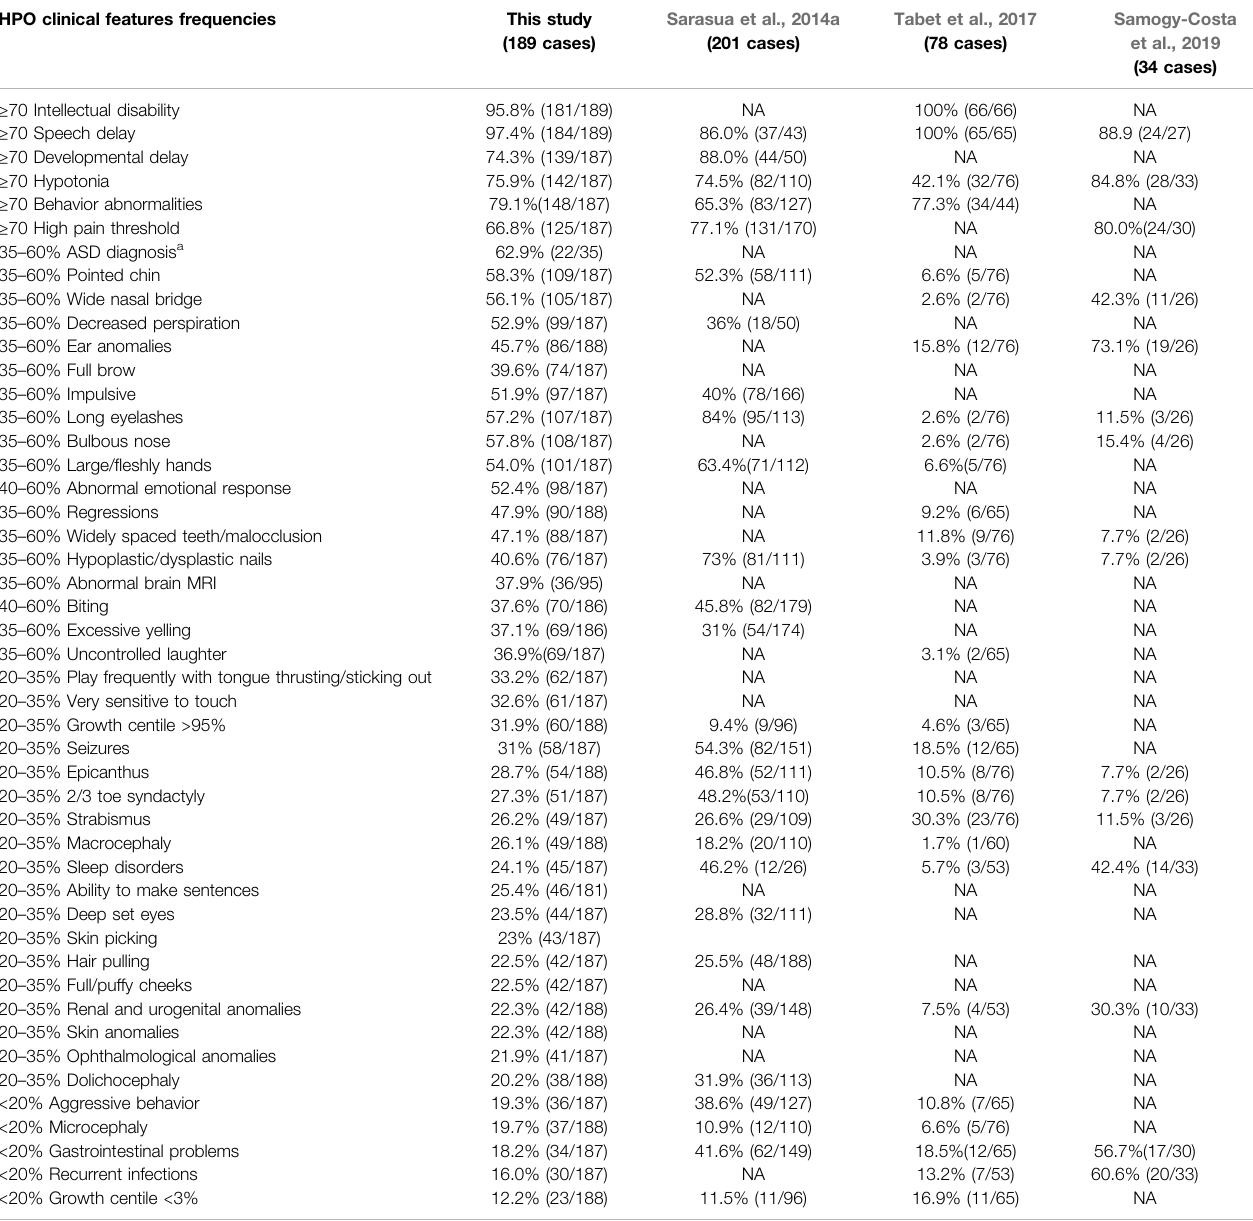
TABLE 2 | Frequency of clinical features observed in this cohort. a) Microdeletions at